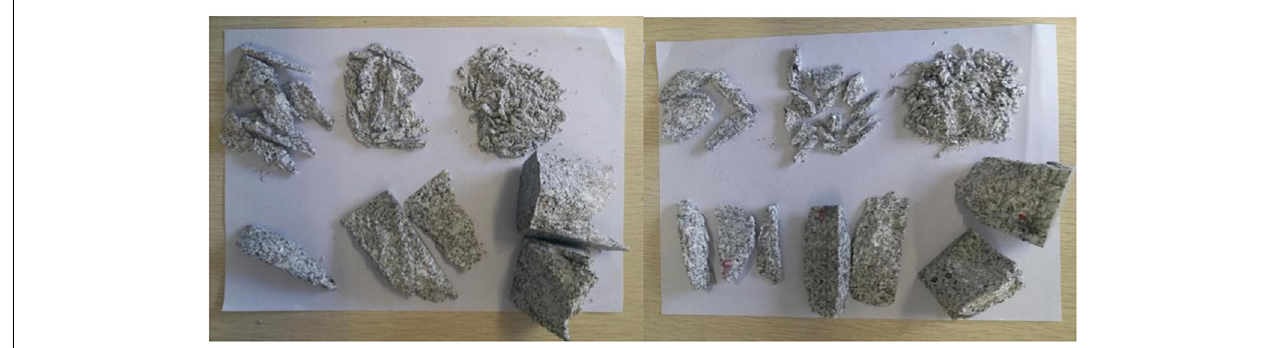
FIGURE 10 | Fracture status of granite after rockburst. (Left) Dry granite, (Right) Saturated water granite. The statistical results of the block degree are shown in Table 3 .